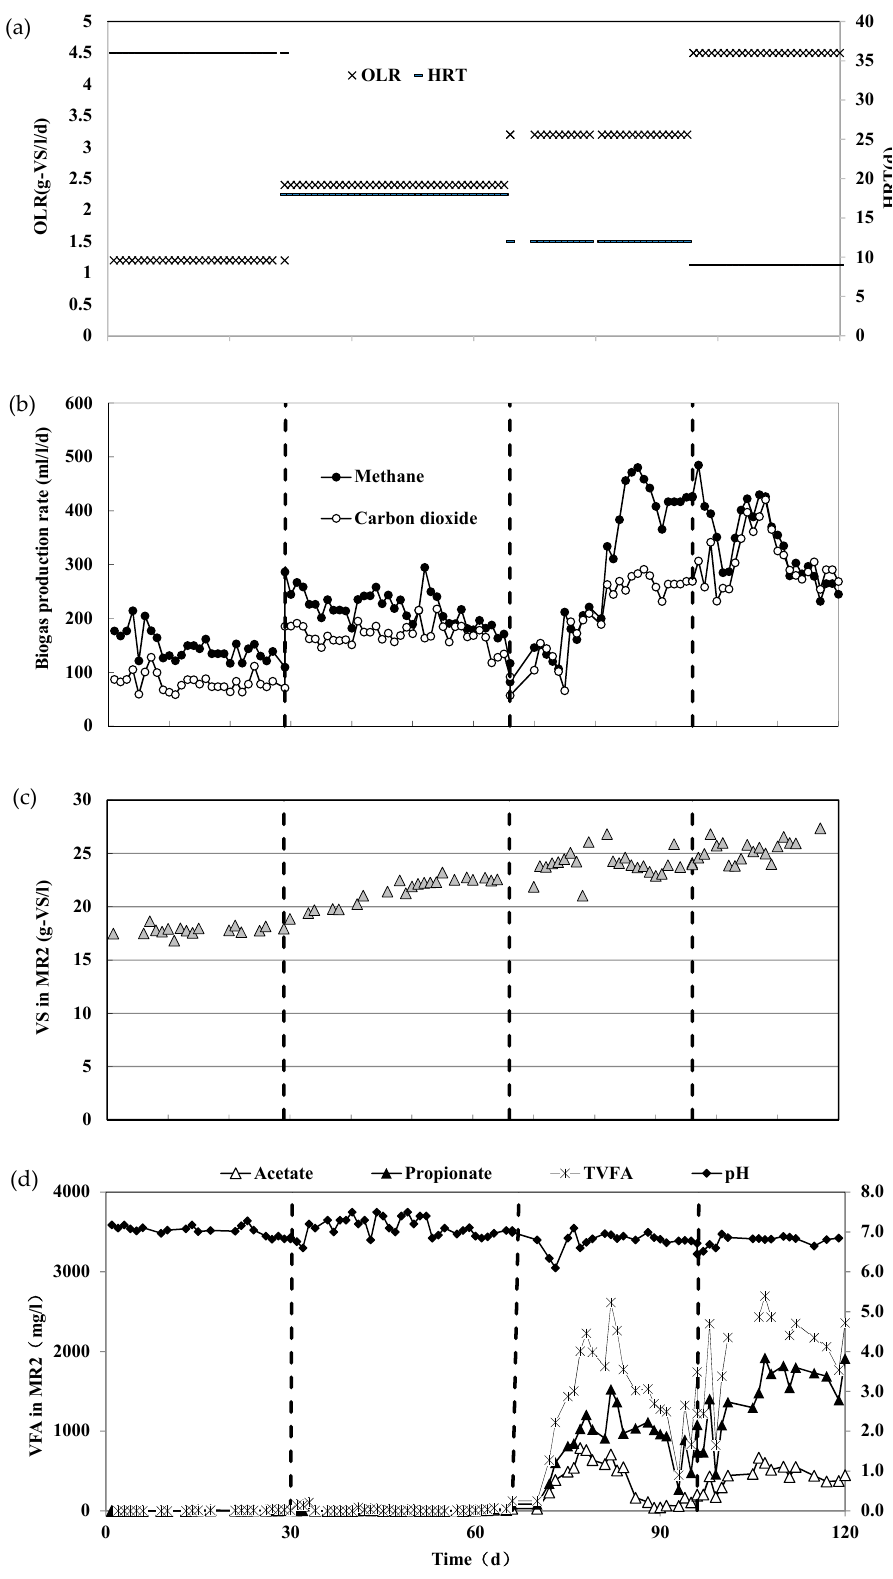
Figure 4. Time courses of biogas production rate, VS, pH, acetate, propionate and TVFA in MR2 at various HRT and OLR. ( a ) HRT and OLR conditions in MR2; ( b ) Methane and carbon dioxide production rates in MR2; ( c ) VS concentration in MR2; ( d ) acetate, propionate and TVFA contents, and pH in MR2.